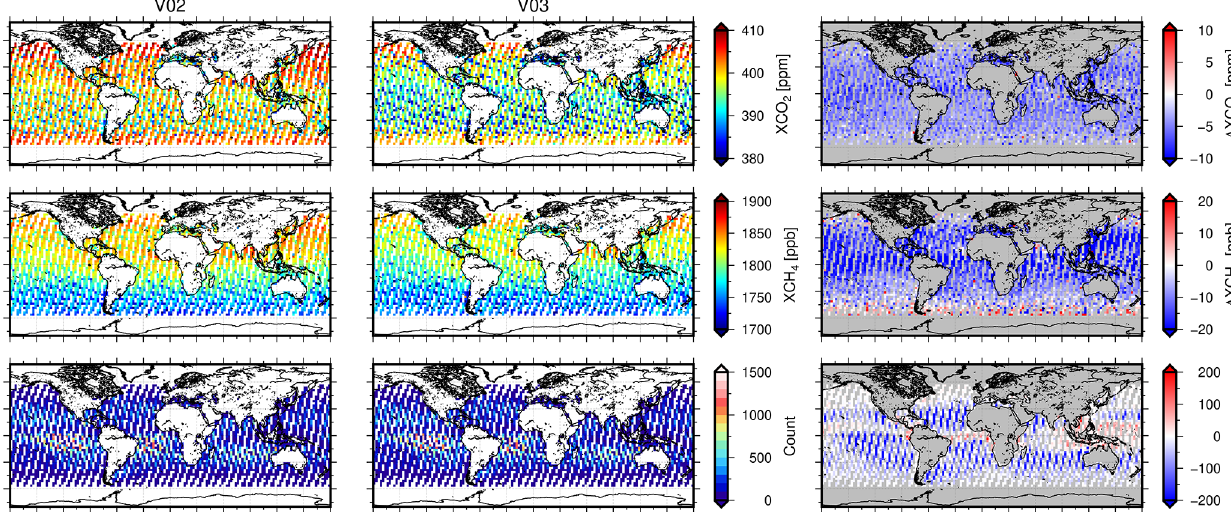
Figure 6. Same as Fig. 5, but for over the